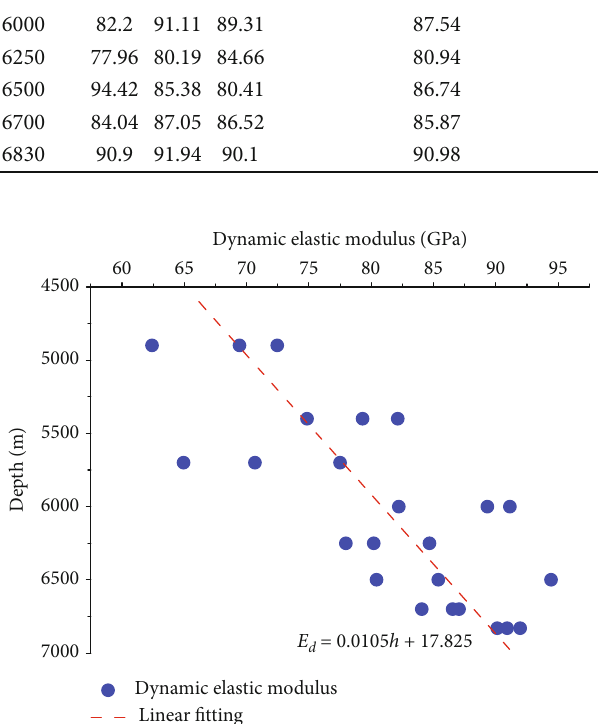
Figure 8: Relation curve between dynamic elastic modulus and